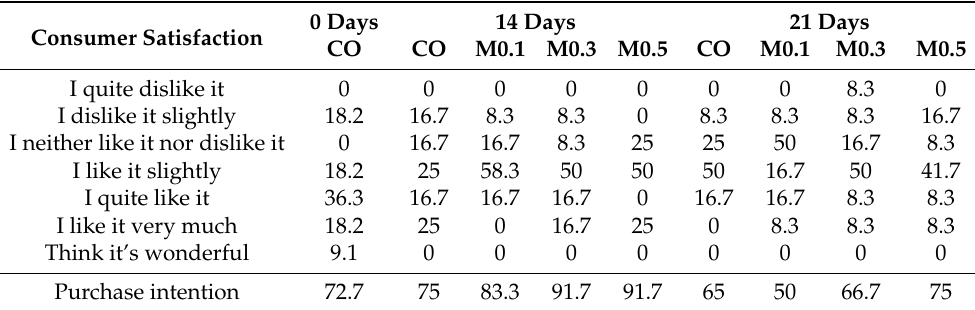
Table 3. Degree of disliking/liking (%) and purchase intention (%) of ‘Samba’ cherries in relation to storage time and